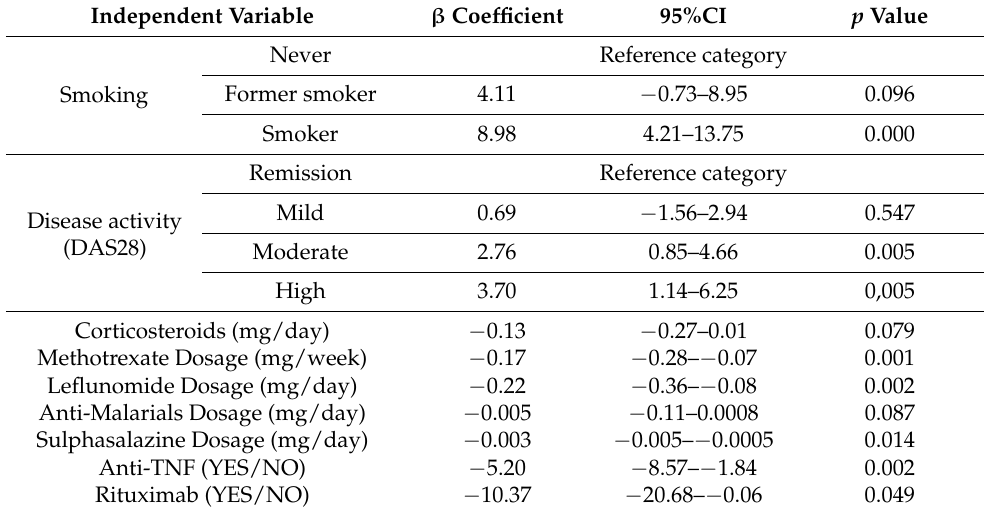
Table 4. Multivariate analysis showing variables associated with the evolution of anti-CCP2 titers. Adjusted model with disease activity assessed by